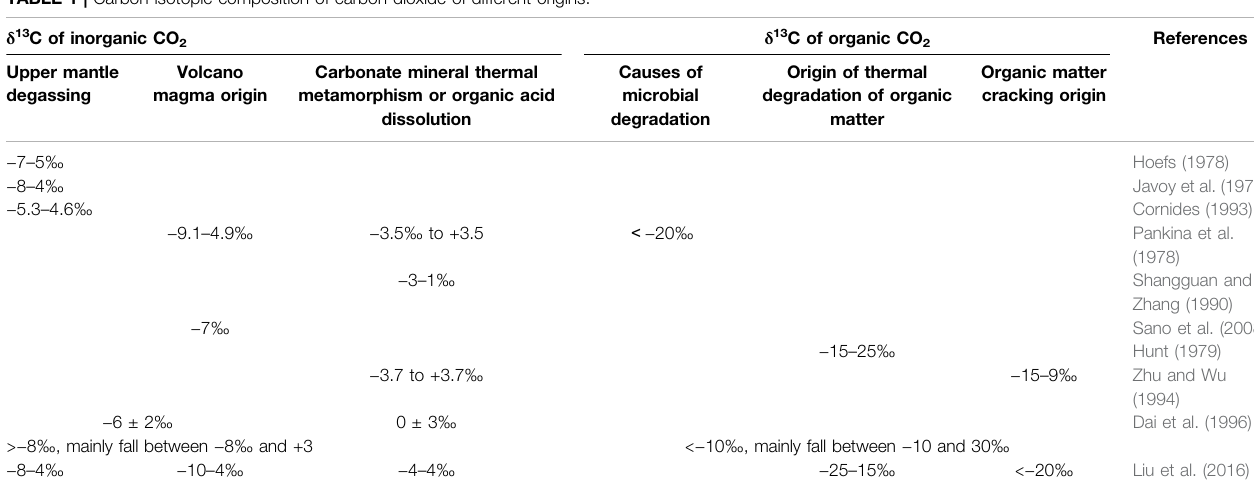
TABLE 1 | Carbon isotopic composition of carbon dioxide of different